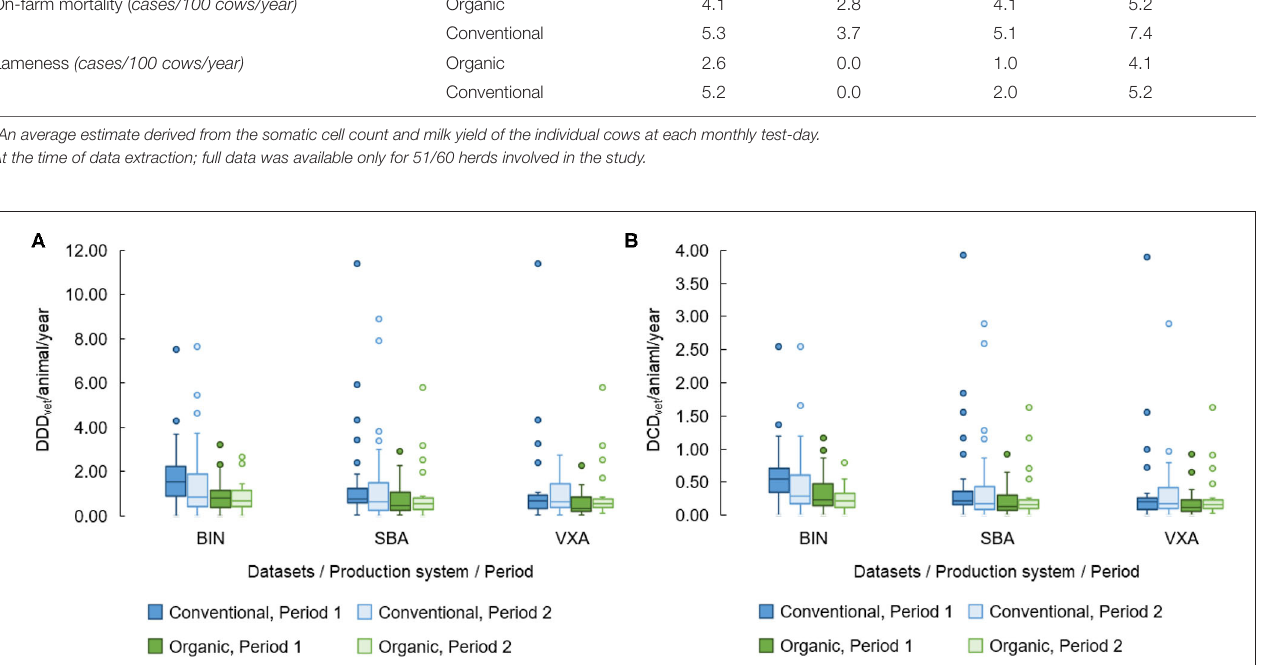
FIGURE 2 | Distribution of (A) herd total number of defined daily doses per animal/year (DDD vet /animal/year) and (B) herd total number of defined course doses (DCD vet /animal/year) per animal/year in a sample of organic ( n = 30) and conventional ( n = 30) Swedish dairy herds reported across two periods and three datasets. Box = the range between the 1st and 3rd quartiles; horizontal line = median; lower and upper whisker = interquartile range; dots = outliers. BIN, Bin collection method records, n = 57 and n = 55 herds had reported use in P1 and P2, respectively. SBA, Swedish Board of Agriculture database, n = 51 and n = 53 herds had reported use in P1 and P2, respectively. VXA, Växa Sverige database; n = 48 and n = 48 had reported use in P1 and P2,